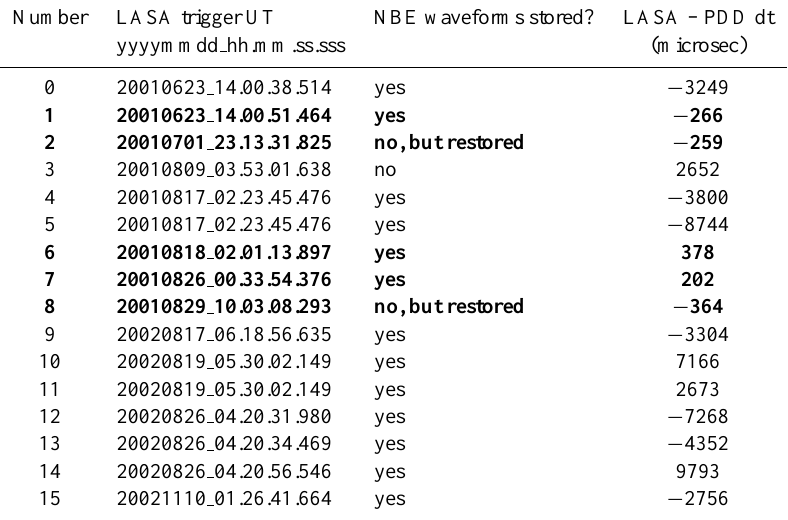
Table 2. Sixteen LASA/PDD coincidences within ± 10ms. Boldfaced lines are for the 5 cases of | dt | within the central peak of histogram